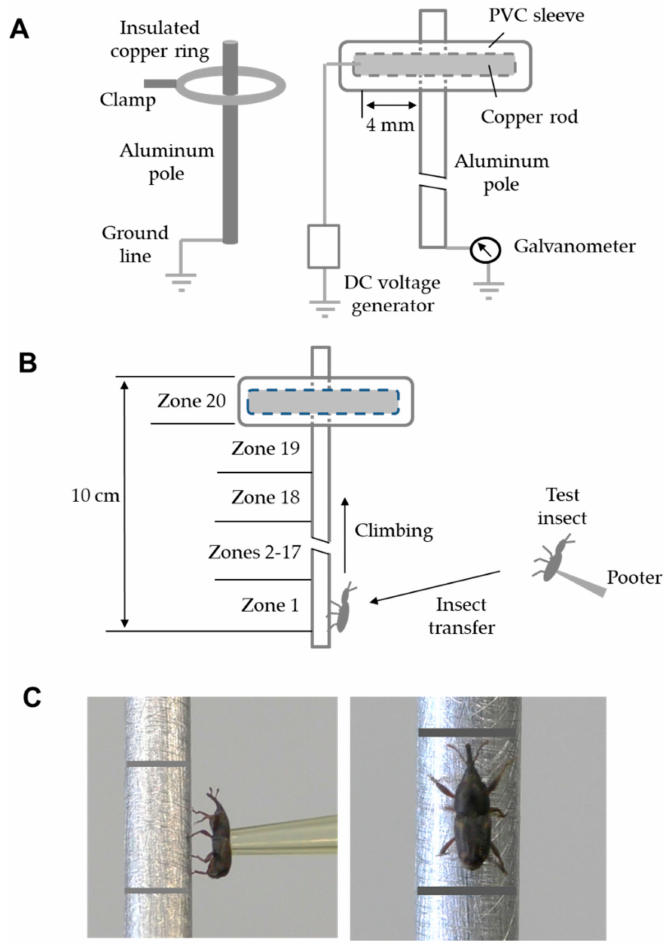
Figure 2. ( A ) Schematic representation of the electrostatic instrument used in the pole-climbing assay and its cross-sectional view, ( B ) insect transfer to zone 1 of a grounded aluminum pole, and ( C ) photographic demonstration of a rice weevil being held using the tip of the pooter (left) and then being placed on the aluminum pole (right). PVC, polyvinyl